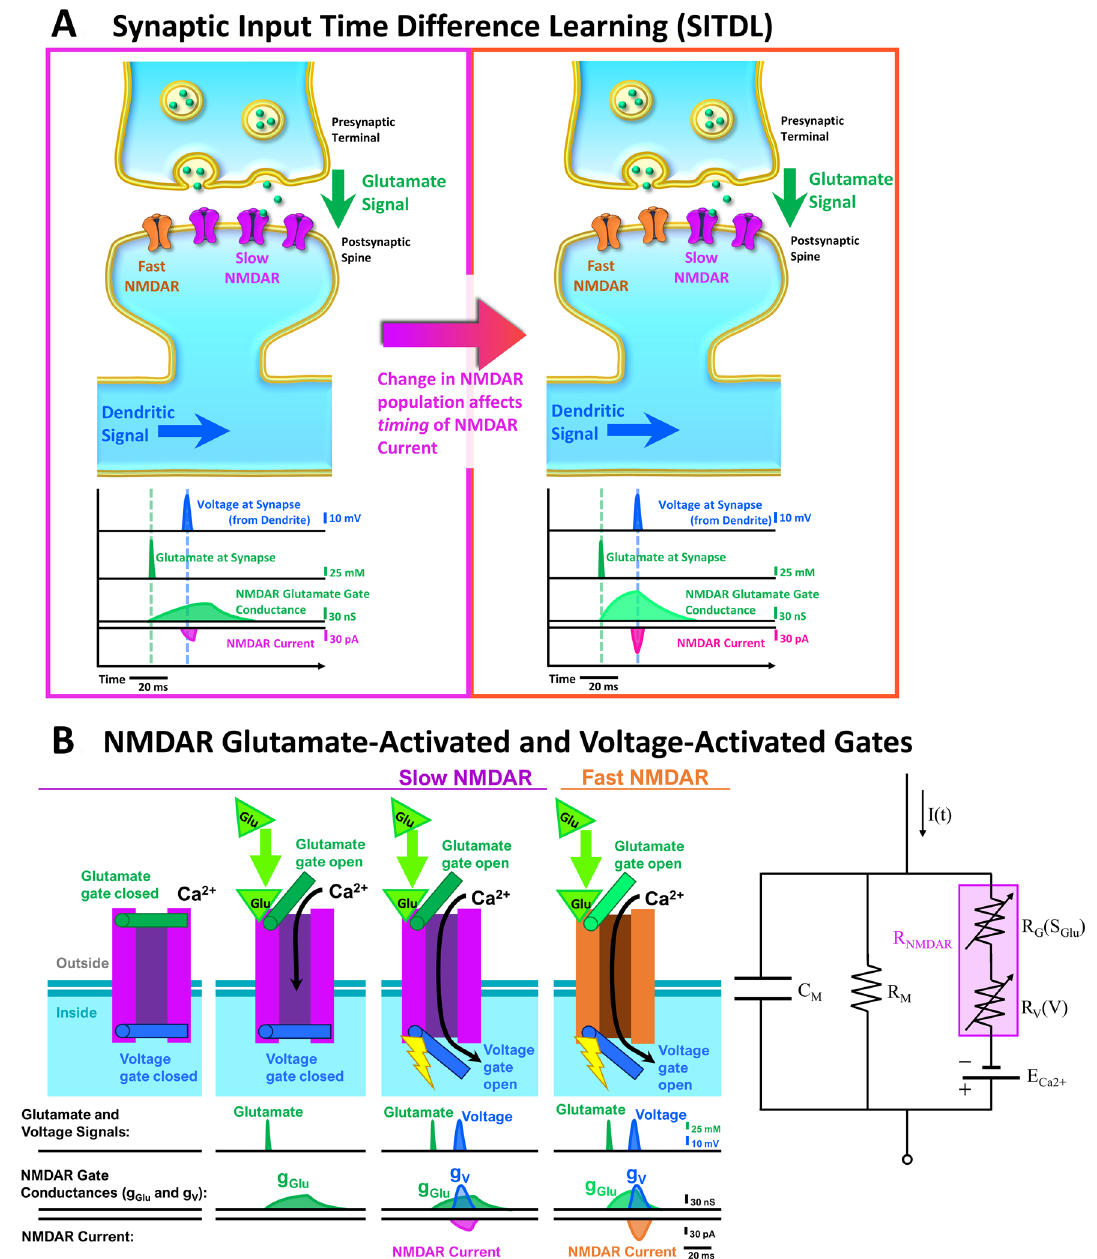
Figure 1. The SITDL hypothesis: An example of how activity-dependent changes in NMDAR population can affect synaptic current timing. ( A) Left: A developing silent synapse starts with a majority of slow NMDARs with slower glutamate gate activation than fast NMDARs. The synapse receives a glutamate signal followed later by a dendritic voltage signal, causing a difference in activation of NMDARs’ voltage and glutamate gates. Right: As the synapse develops and experiences the same timing between voltage and glutamate signals, its NMDAR population may change, caused by the difference in glutamate and voltage gate activation. In this case, fast NMDARs replace slow NMDARs until the gate conductance difference is minimized, thus aligning the overall NMDAR current peak with the peak of the voltage signal. This allows the developing synapse to learn the timing difference between the voltage and glutamate signals by encoding it in the NMDAR population’s glutamate gate activation time. ( B ) Left: Each NMDAR has a glutamate gate and a voltage gate that can be activated independently, with corresponding gate conductances shown. Coincident activation of both gates allows influx of Ca 2+ (NMDAR Current). A slow NMDAR has a slower glutamate gate activation, therefore experiencing slower change in glutamate gate conductance than a fast NMDAR. Right: Circuit diagram of a post-synaptic spine containing only NMDARs. An NMDAR (R NMDAR ) is shown as variable serial resistances of its glutamate gate (R G ) and voltage gate (R V ) that depend on the glutamate signal (S Glu ) and dendritic spine’s voltage (V), respectively. C M denotes the membrane capacitance, R M the membrane resistance, E Ca2+ the cell’s Nernst potential for Ca 2+ , and I(t) the external